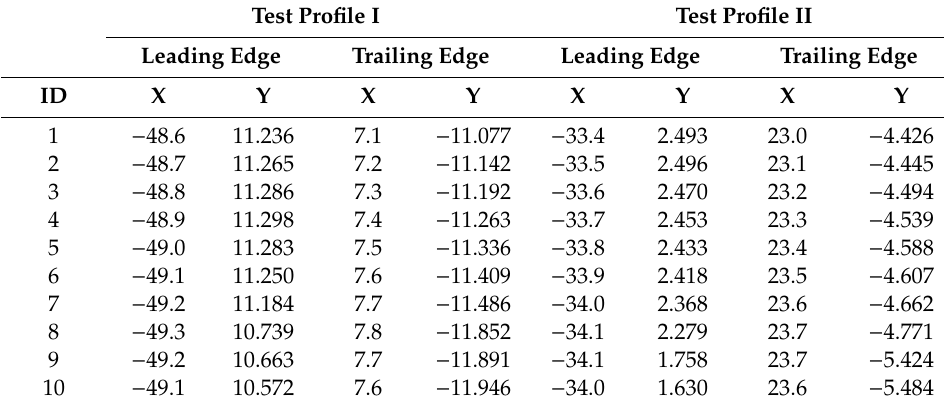
Table 1. Measurement coordinates of the test profiles (unit: